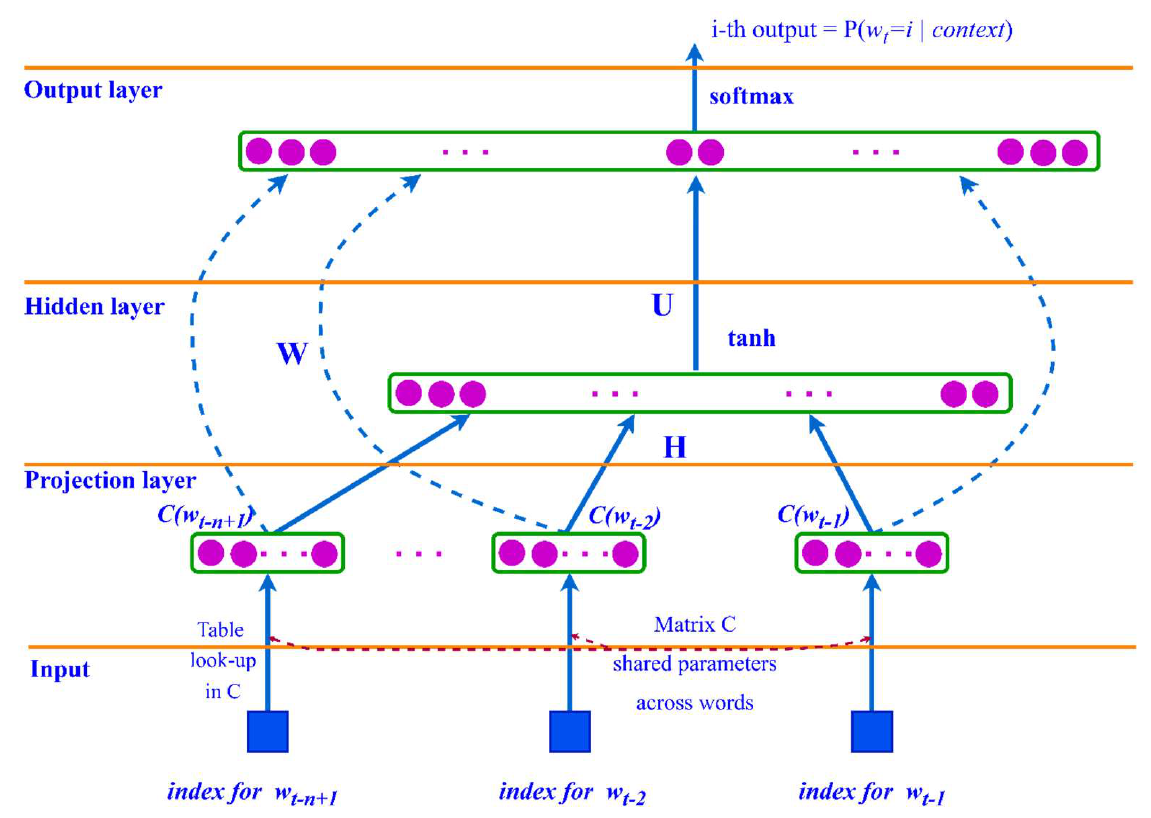
Figure 4. FFNN language model architecture.